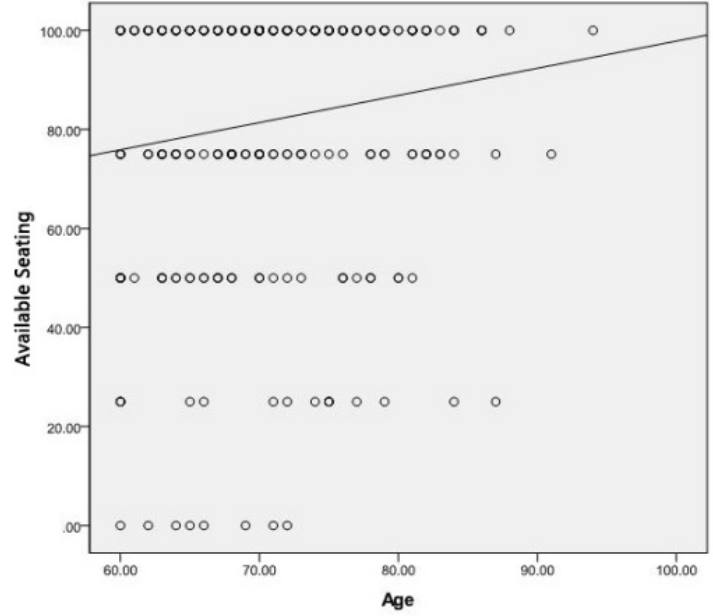
Figure 16. Scatter plot with fit line at total for ‘available seating’ by age.